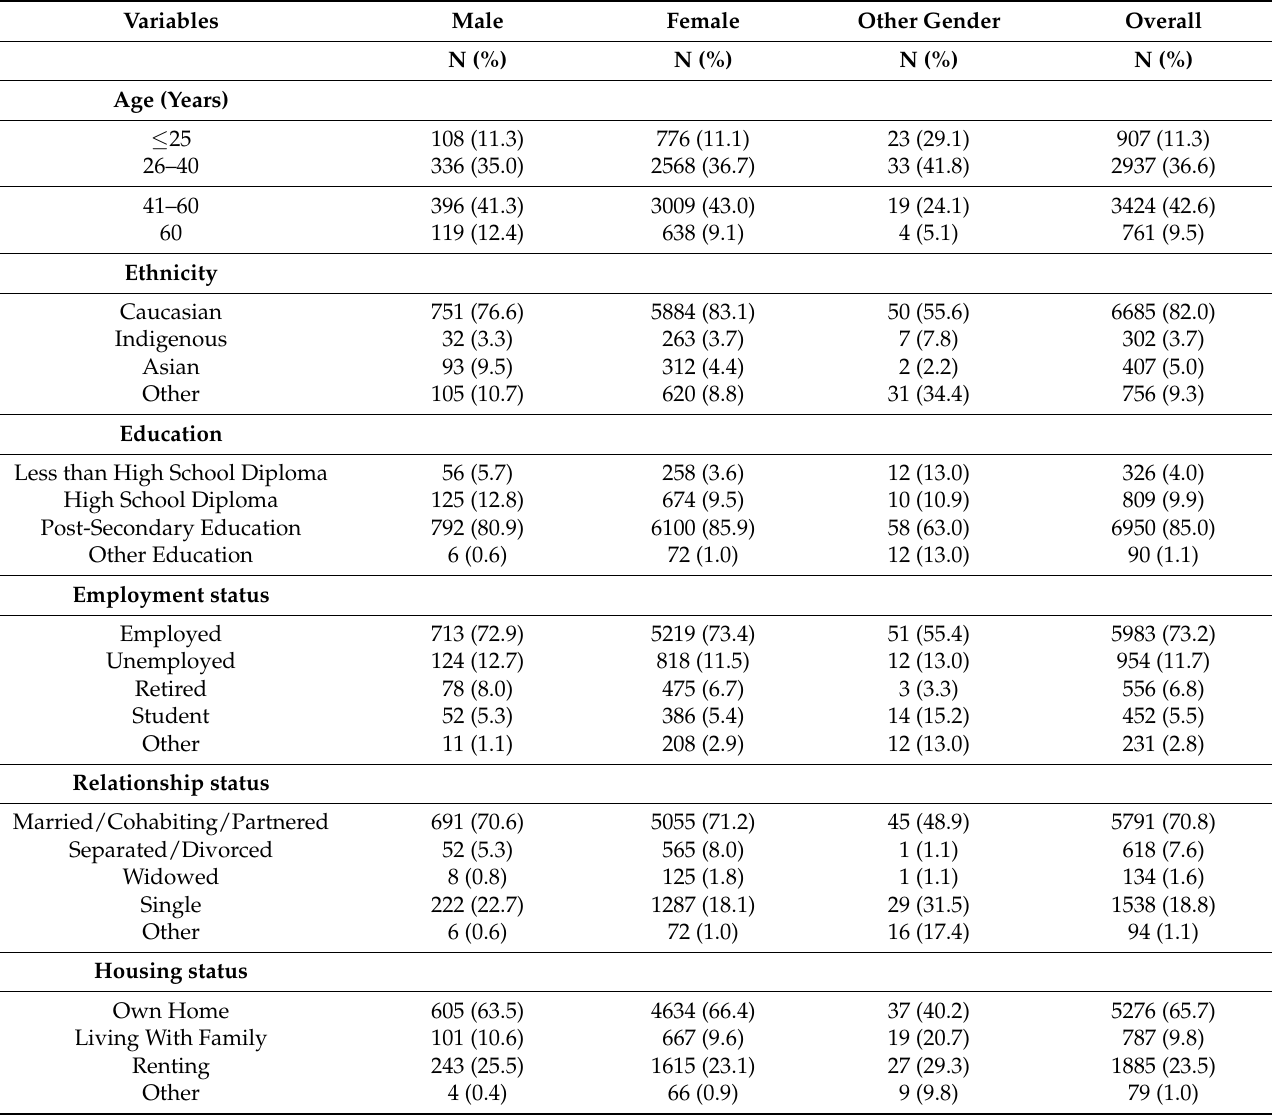
Table 1. Gender identity distribution of demographic characteristics of